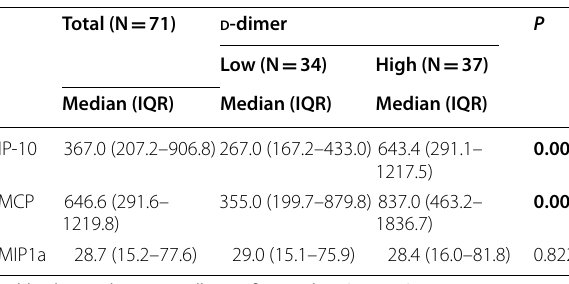
and thrombosis-related ELISA indicators in 71 COVID-19 patients stratified according to high ( median) versus low (< median) d -dimer, grouped ≥ according to survival and death